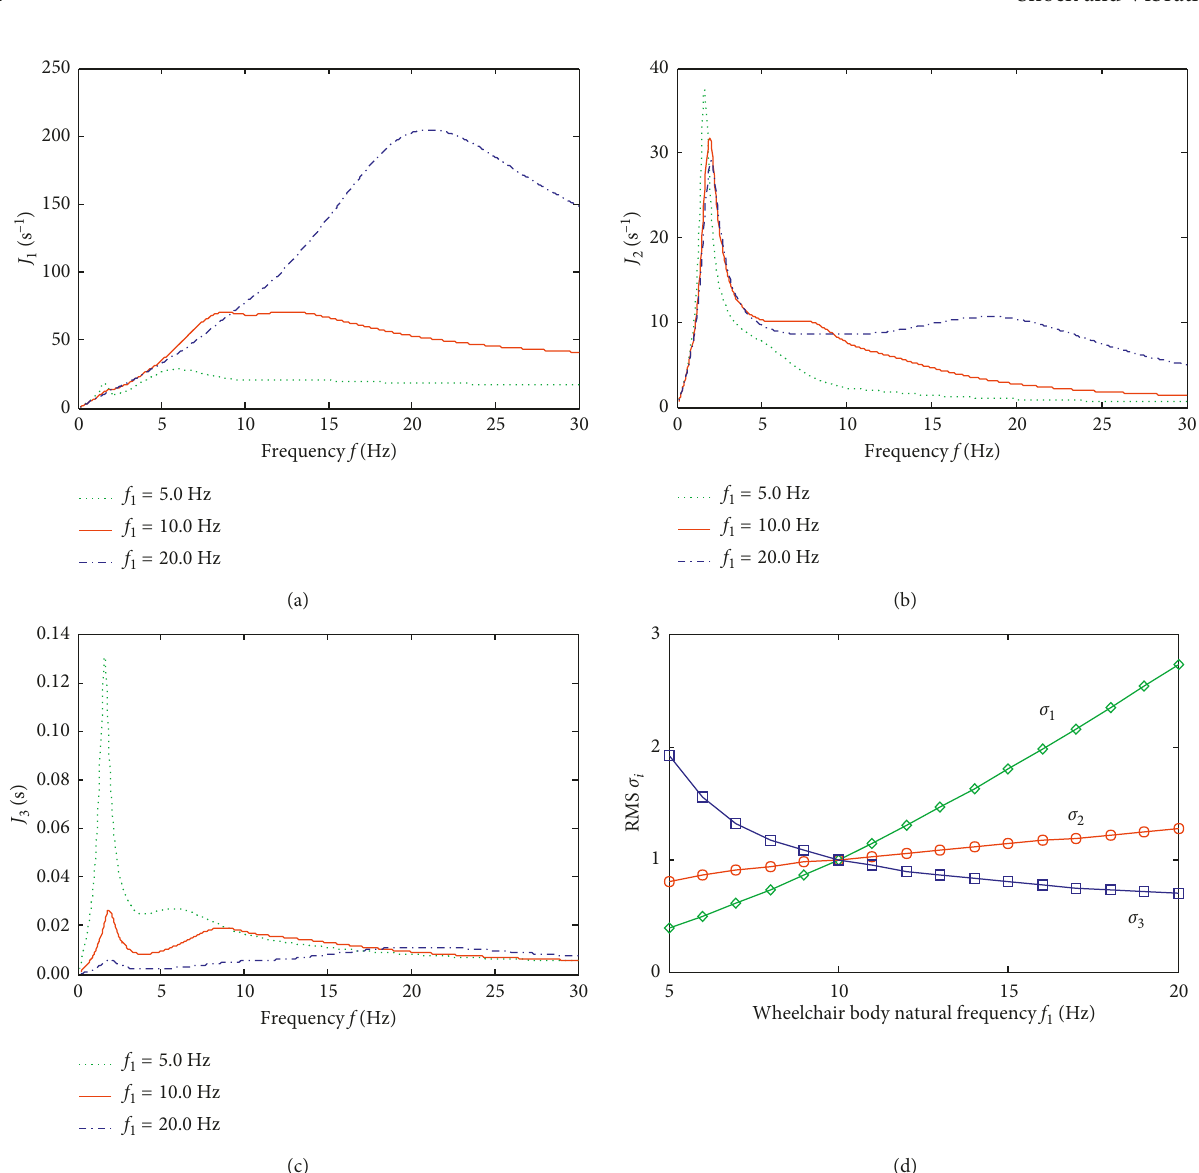
at different values of f 1 at different values of f 3